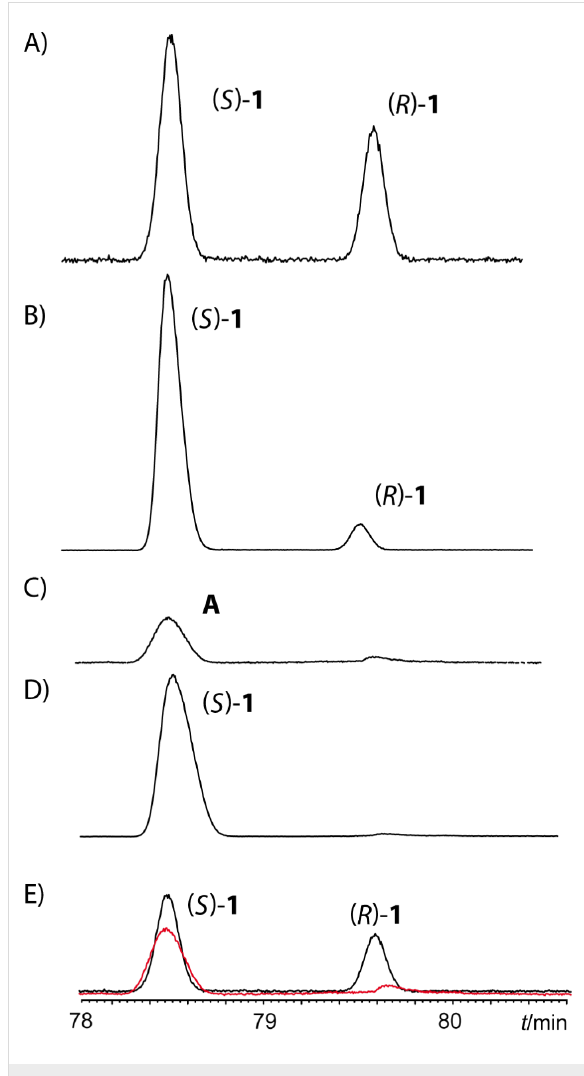
Figure 4: Total ion chromatogram of the enantiomer separation of ( Z )- 1 on a chiral β -TBDMS- Hydrodex phase. Temperature program: isothermal for 60 min at 110 °C, then with 2 °C/min to 160 °C, followed by a sharp ramp with 25 °C/min to 220 °C. A) Racemic mixture, B) coinjection of racemic mixture and ( S )- 1 , C) natural extract, D) coin- jection of the natural extract and ( S )- 1 , E) Overlay of A and C showing that the minor peak present in the extract is not the ( R )-enantiomer of 1 . Black: racemate, red: natural extract. Peak identities were con- firmed by mass